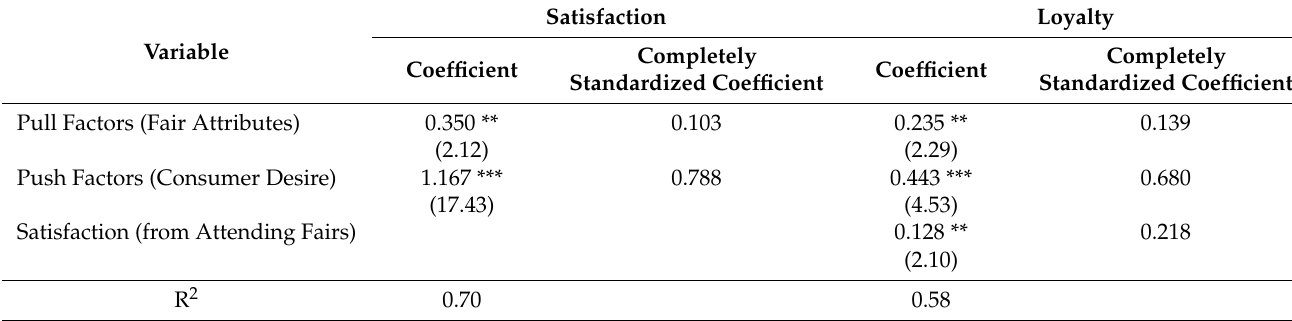
Table 5. Structural model